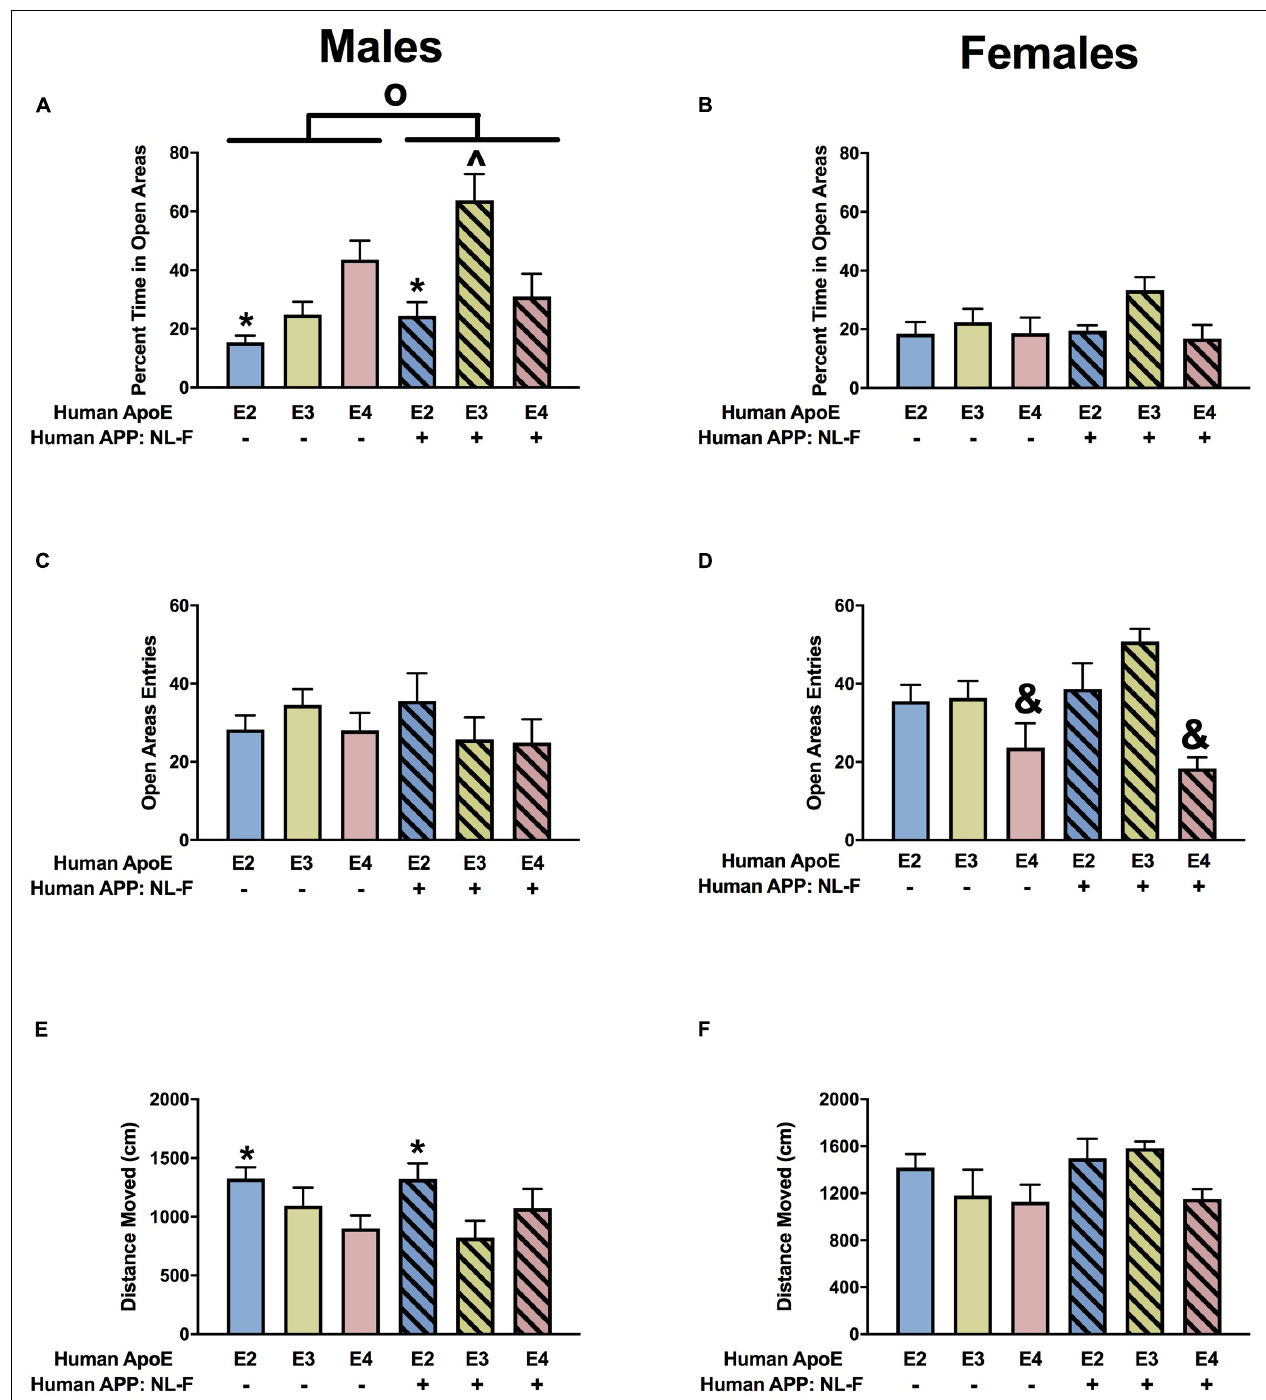
FIGURE 9 | Performance of males (A,C,E) and females (B,D,F) in the elevated zero maze at the 18-month time point. (A) There was an effect of APOE, APP, and an APP × APOE interaction for percent time spent in the open areas in the elevated zero maze. E2 males showed higher measures of anxiety than E3 and E4 males. * p < 0.05. NL-F mice showed lower measures of anxiety. NL-F/E3 males showed lower measures of anxiety than NL-F/E4 and E3 males. ˆ p < 0.05. (B) There was a trend toward an effect of APOE on time spent in the open areas of the elevated zero maze in females, with a trend toward lower measures of anxiety in E3 than E4 females. (C) Entries of males into the open areas of the elevated zero maze. (D) There was an effect of APOE on entries into the open areas of the elevated zero maze. E4 females entered the open areas less than E2 and E3 mice. & p < 0.05. (E) There was an effect of APOE on activity levels of males in the elevated zero maze. E2 males showed higher activity levels than E3 and E4 males. * p < 0.05. (F) Activity levels of females in the elevated zero maze.